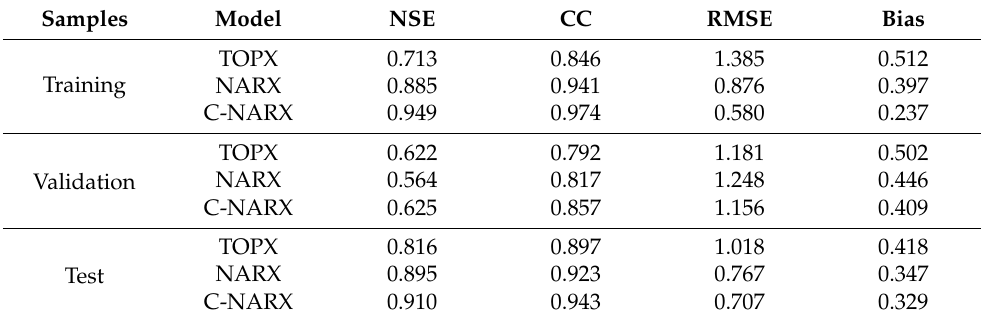
Table 5. Comparison of the simulation results based on the TOPX, NARX and C-NARX models.